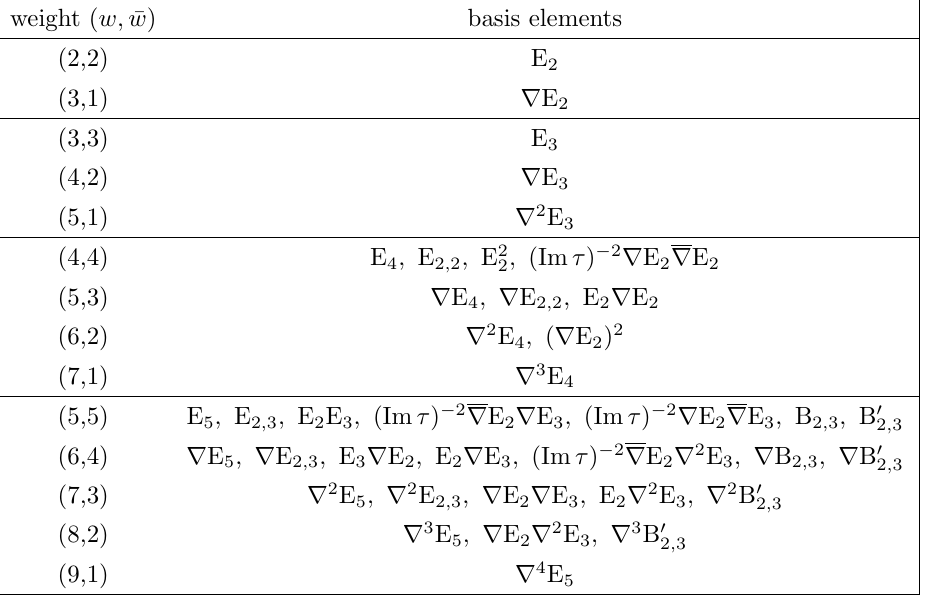
Table 1 . Basis of MGFs of modular weight w + (cid:22) w (cid:20) 10 in terms of r k E ::: and imaginary cusp forms and their derivatives. There is a similar basis with (cid:22) w > w where r is replaced by r and B ::: by B ::: . The modular weights ( w; (cid:22) w ) refer to the lattice sums C [ : : : ] after stripping o(cid:11) overall suitable factors of (Im (cid:28) ) k . For instance, E k is counted as ( w; (cid:22) w ) = ( k; k ) from the lattice-sum